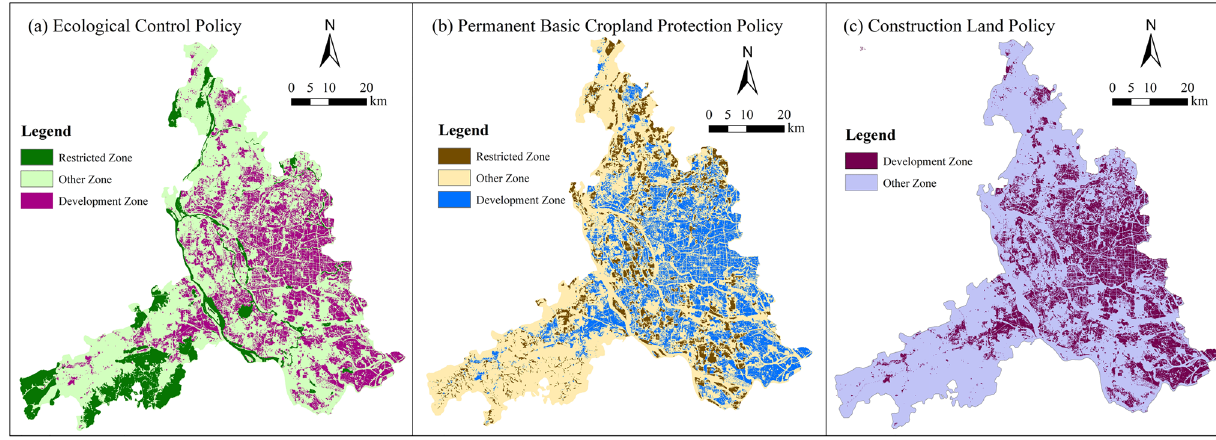
Fig. 6 Policy restrictions for three